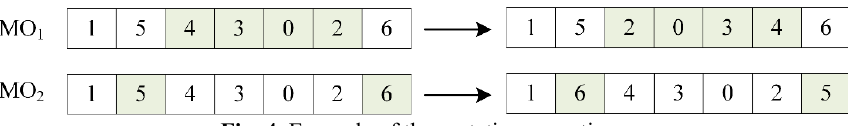
Fig. 4. Example of the mutation